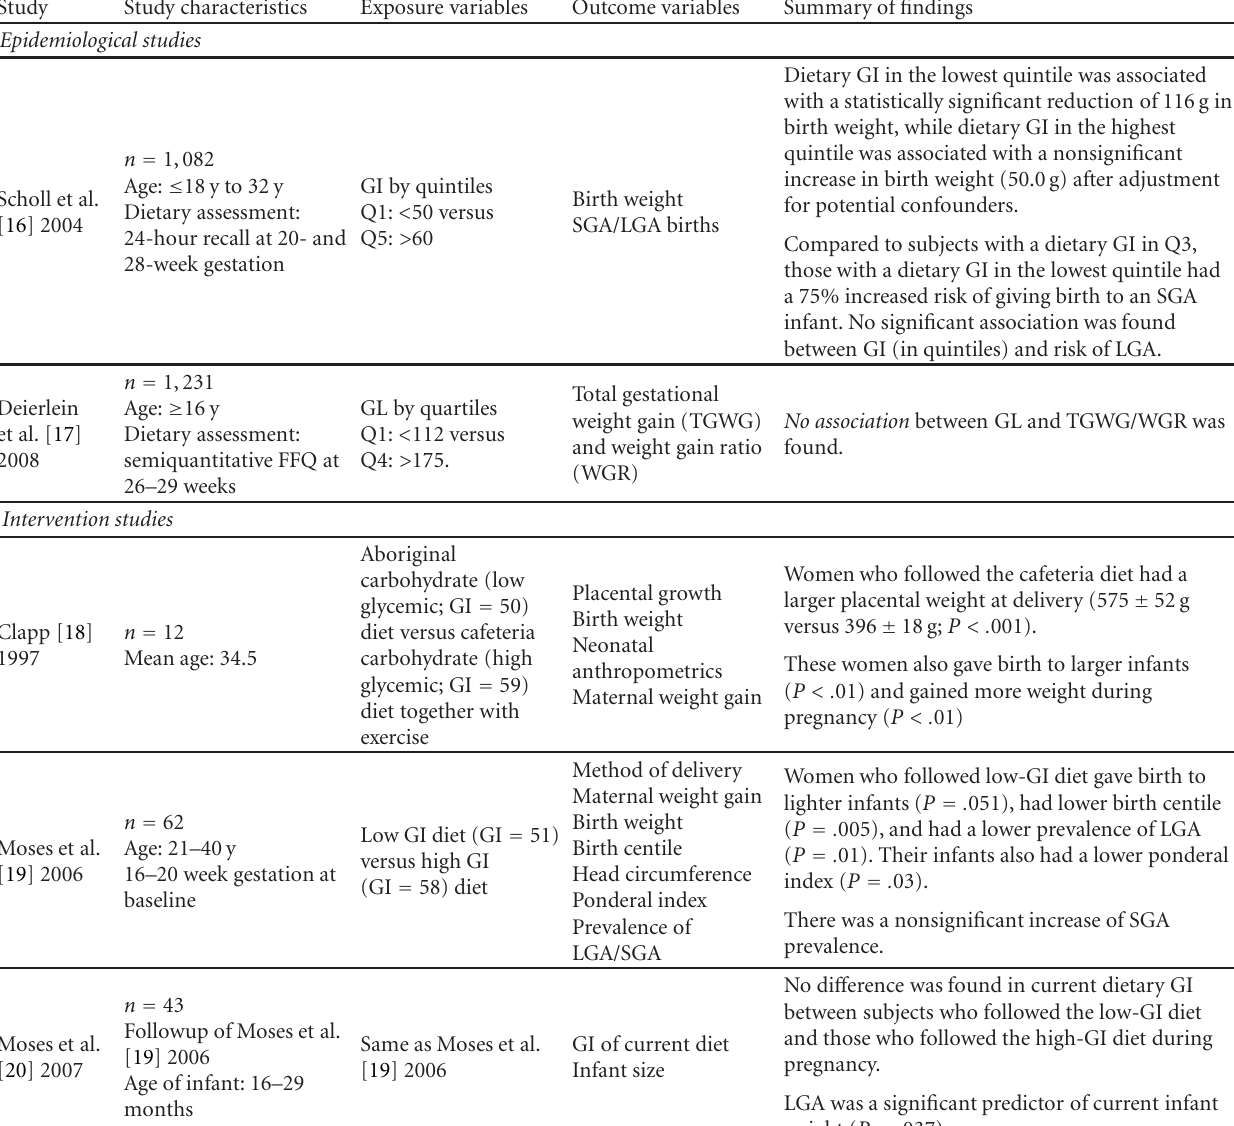
Table 1: Characteristics and outcome measures of studies examining the association between glycemic index/glycemic load and pregnancy outcomes in healthy